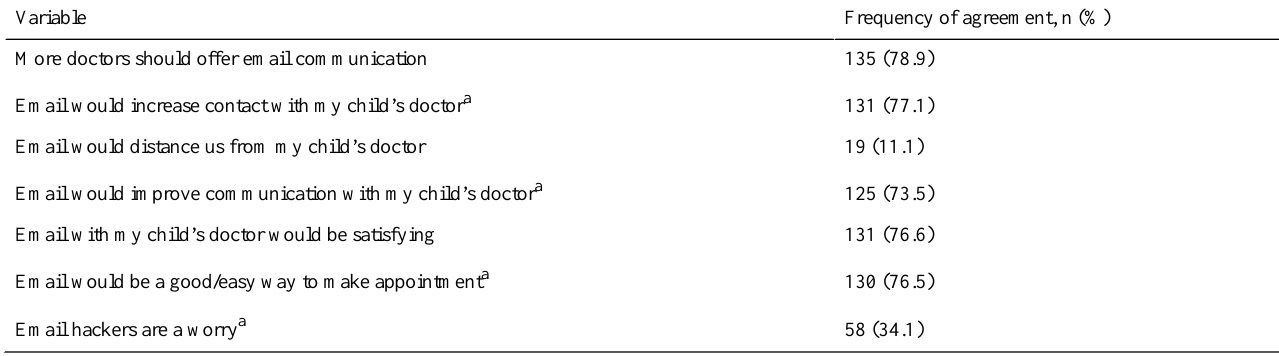
Table 3. Email users attitudes toward email communication with doctors (n=171).